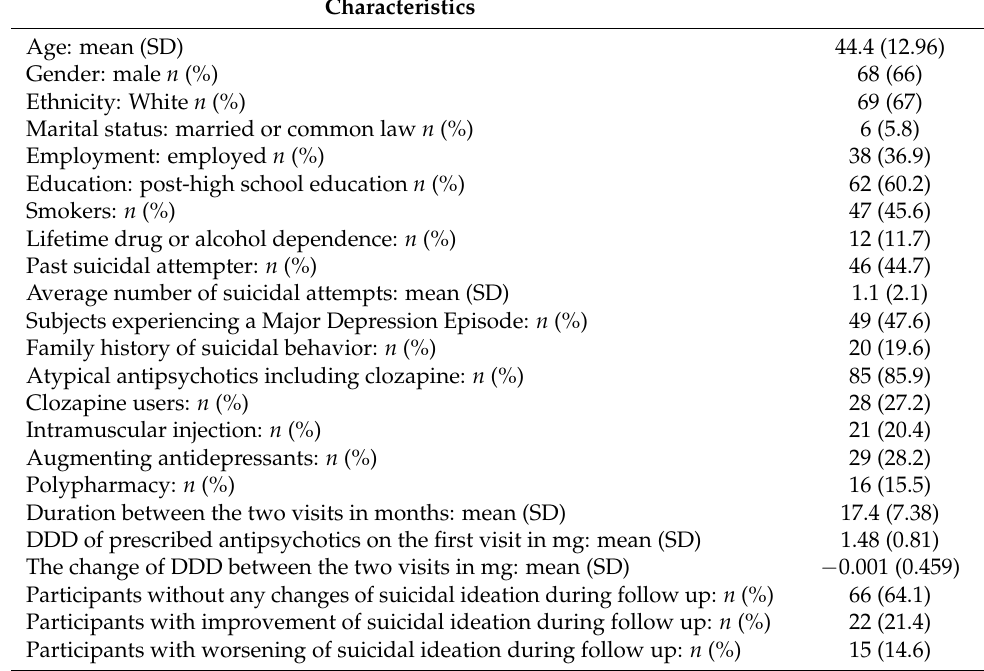
Table 1. Clinical and Demographics of our sample ( n = 103).